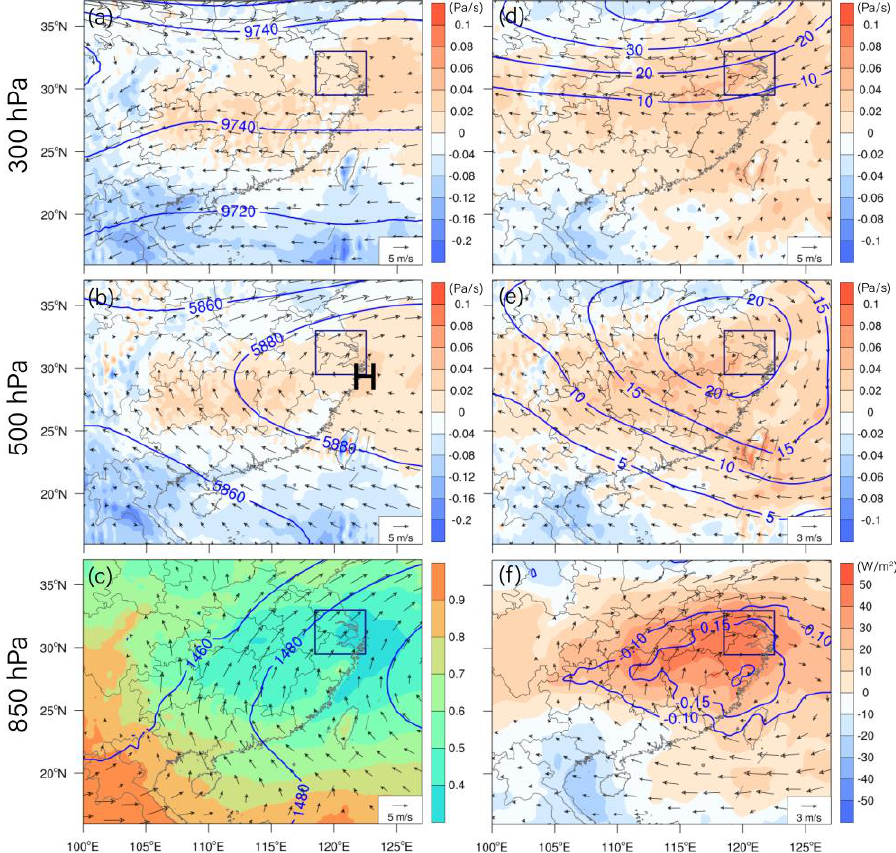
Figure 5. Synoptic backgrounds for the YRD-only heatwaves. ( a ) The 300 hPa geopotential height (blue contours; unit: gpm), horizontal wind vector (arrows), and vertical velocity (shadings). ( b ) Same as ( a ), but at 500 hPa. ( c ) Geopotential height (blue contours; unit: gpm) and horizontal wind vector (arrows) at 850 hPa, and total cloud cover (shadings). ( d ) Anomalies of geopotential height (blue contours; unit: gpm), horizontal wind vector (arrows), and vertical velocity (shadings) at 300 hPa. ( e ) Same as ( d ) but at 500 hPa. ( f ) Anomalies of total cloud cover (blue contours), 850 hPa horizontal wind vectors (arrows), and net solar radiation at the surface (shadings; positive downward). Navy rectangle denotes the YRD region. Gray lines indicate the national and provincial boundaries and coastal lines.